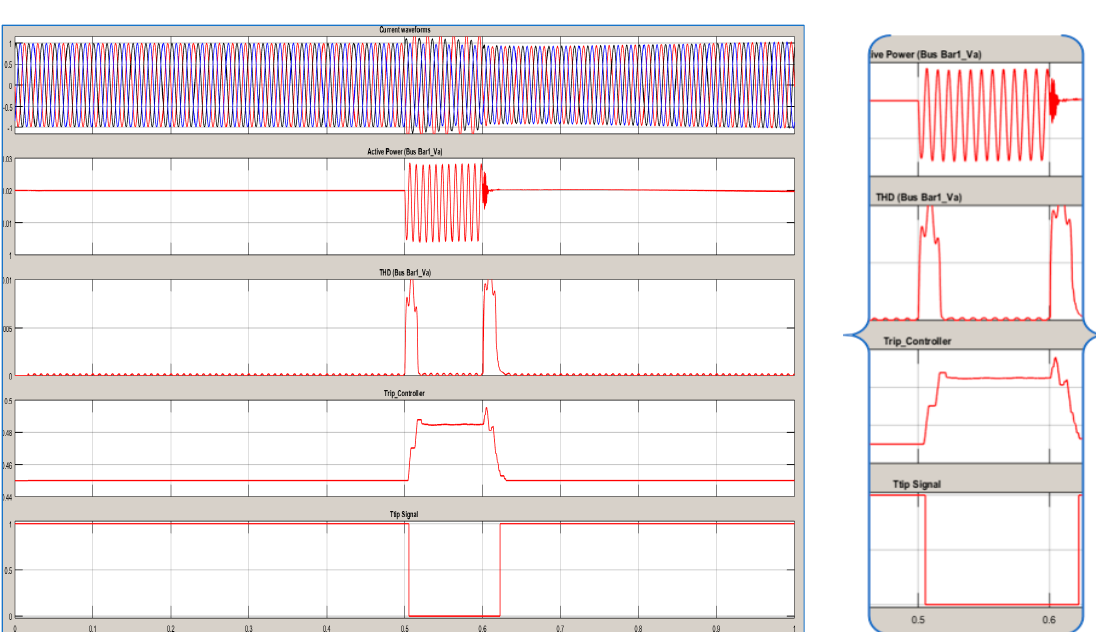
Figure 21. Double line fault voltage waveform.